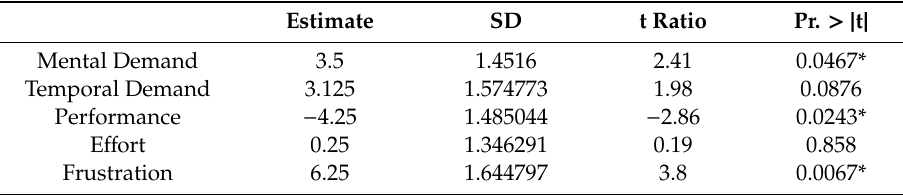
Table 7. Results of t-test for each